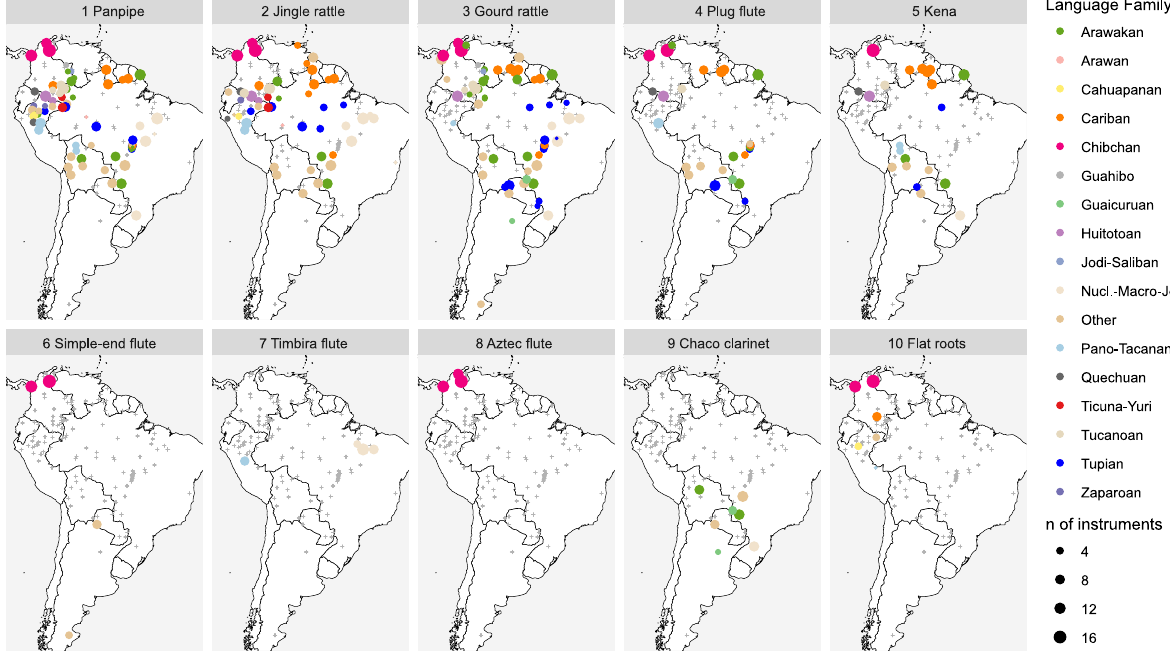
Fig. 4 Distribution of musical instruments. Distribution of 10 of the 57 instruments of the Izikowitz database, characterized by differential patterns. ubiquitous (1 – 5), discontinuous (6 – 7), or region-speci fi c (8 –